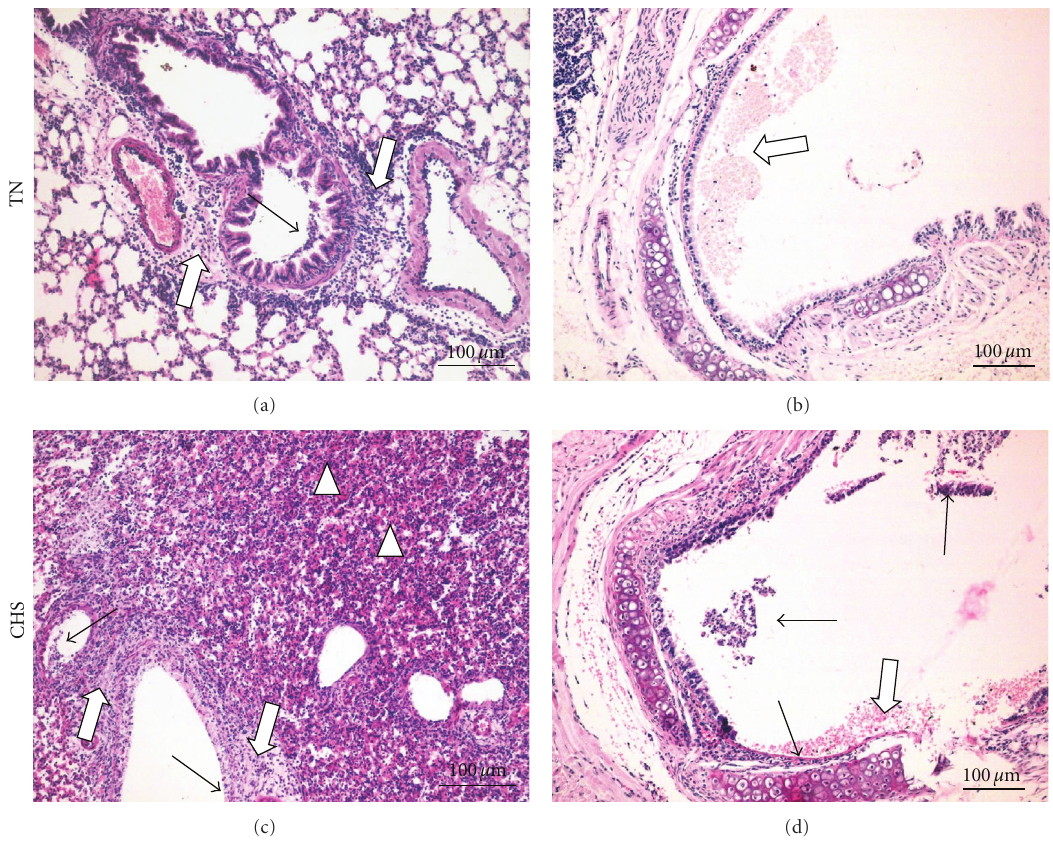
Figure 4: Lung and trachea histopathology following H5N1 infection in mice. Representative lung or trachea sections from each group were stained by H&E (400 × ). (a) The lung lesions in the TN group of mice showed peribronchiolitis. Solid arrows indicate a reduction in the number of mucous epithelial cells in bronchioles, and unshaded arrows indicate interstitial edema and inflammatory cellular infiltration around small blood vessels and the bronchioles. (b) The tracheal lesions in the TN group of mice. Unshaded arrows indicate erythrocyte infiltration. (c) The lung lesions in the CHS group of mice showed severe alveolitis, peribronchiolitis, and bronchopneumonia. The solid arrows indicate a reduction in necrosis and the number of mucous epithelial cells in bronchioles, with unshaded arrows indicating extreme interstitial edema and vast inflammatory cellular infiltration. Triangles indicate alveolar lumens flooded with edema fluid mixed with exfoliated alveolar epithelial cells, erythrocytes, and inflammatory cells. (d) The tracheal lesions in the CHS group of mice. Solid arrows indicate exfoliation or necrosis of tracheal mucous epithelial cells, and unshaded arrows indicate erythrocytes and inflammatory cellular infiltration in the tube cavity of the